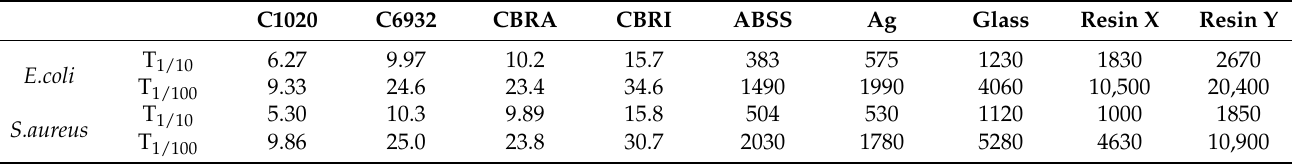
Table 1. Time to reduce the number of viable cells to 1/10 and 1/100 of the inoculated number of cells on the material surface (T 1/10 and T 1/100 , min).